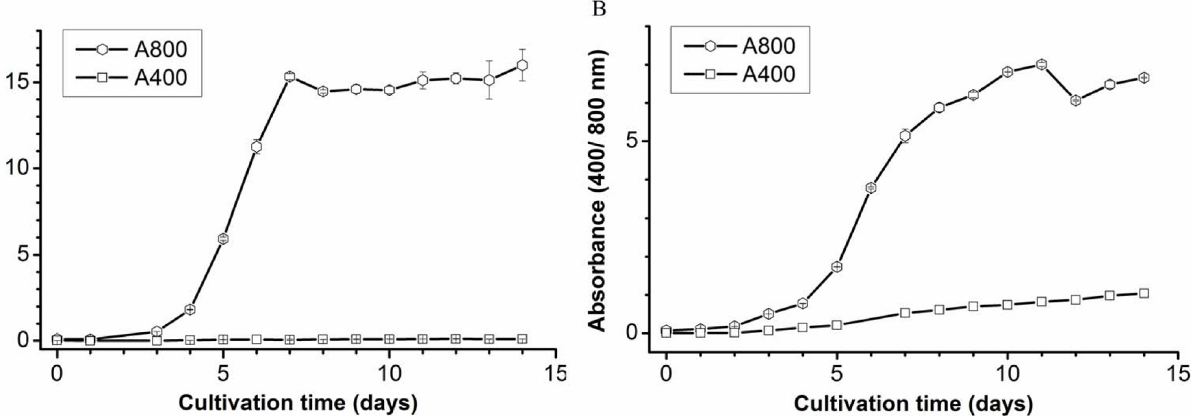
Fig 1. Heterotrophic growth of G . sulphuraria 074G on glucose and production of the porphyrin-like compound. (A) With and (B) without additional aeration. Absorbance 400 nm: Porphyrin-like compound; Absorbance 800 nm: total biomass. Growth curves were determined in triplicate and symbols represent means.